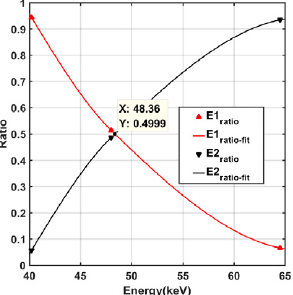
Figure 13. The principle of energy range calibration.